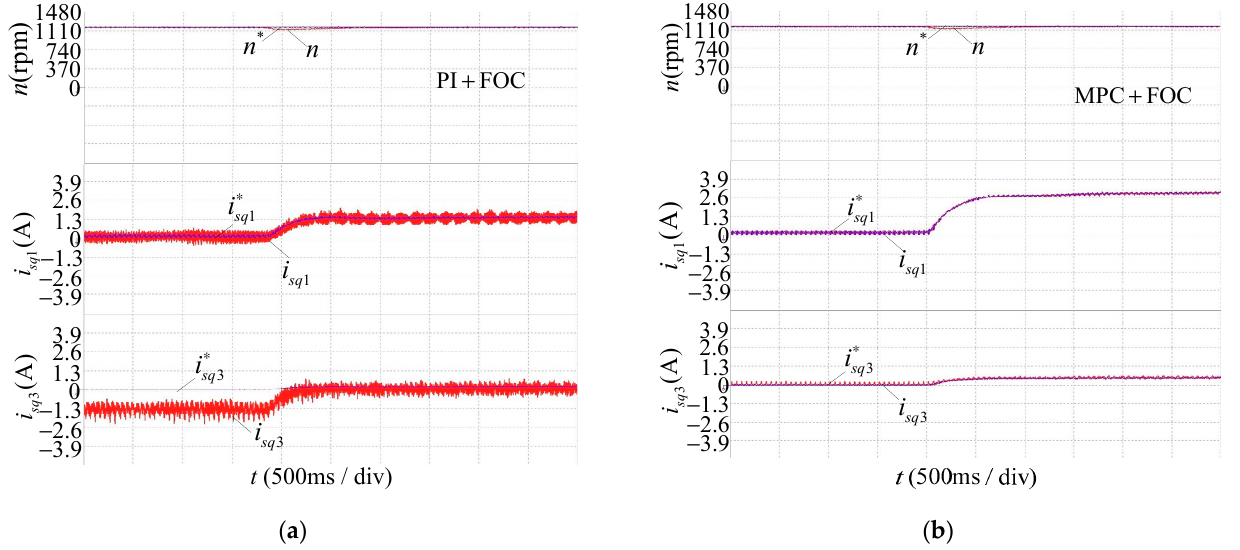
Figure 7. Comparison of two control methods when load disturbance occurs: ( a ) n , i sq 1 and i sq 3 of PI+FOC; and ( b ) n , i sq 1 and i sq 3 of